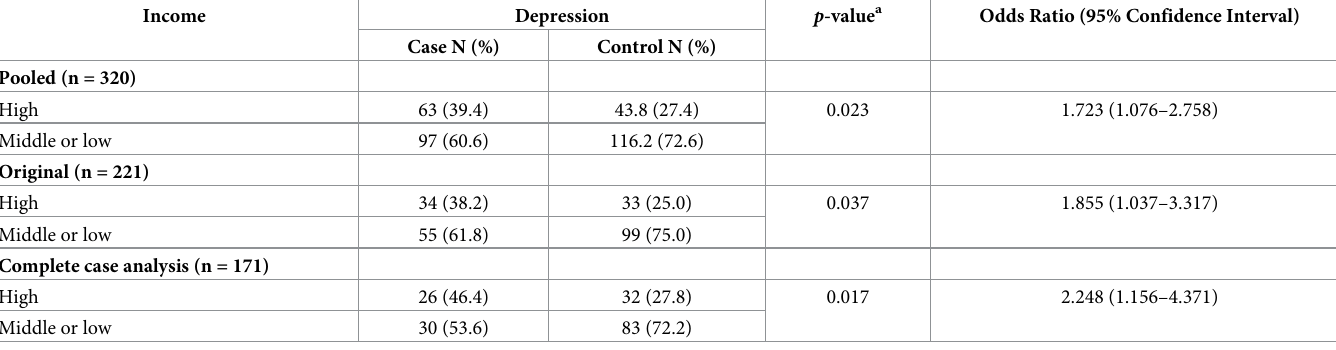
Table 4. Income and patients with depression (High income vs. lower or middle